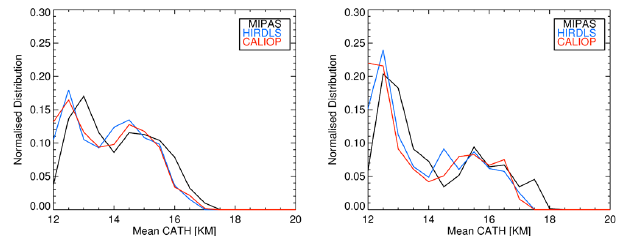
Fig. 7. Normalised frequency distributions of MIPAS and HIRDLS mean gridded CATH for JJA 2007 and DJF 2007/2008 for data from 12km to 20km, between 50 ◦ N to 50 ◦ S on a 5 ◦ latitude and 10 ◦ longitude grid compared to corresponding gridded mean CALIOP